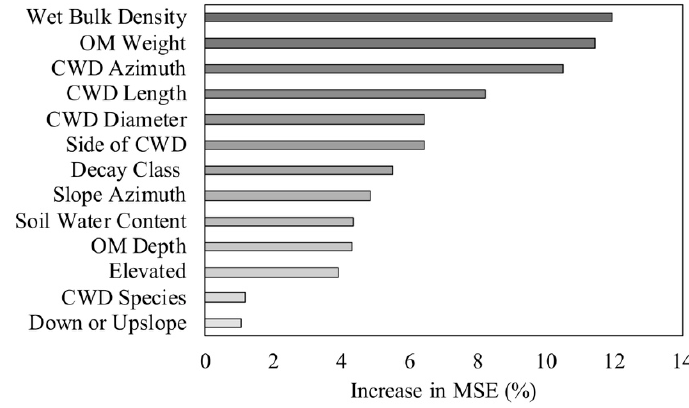
Figure 7. Importance ranking for the influence of coarse woody debris (CWD) attributes and site characteristics on woody plant richness for stems <5 cm dbh in a Pinus palustris woodland after catastrophic disturbance. The increase in mean square error (MSE) indicates the increase in model error when the given variable was randomly permuted.